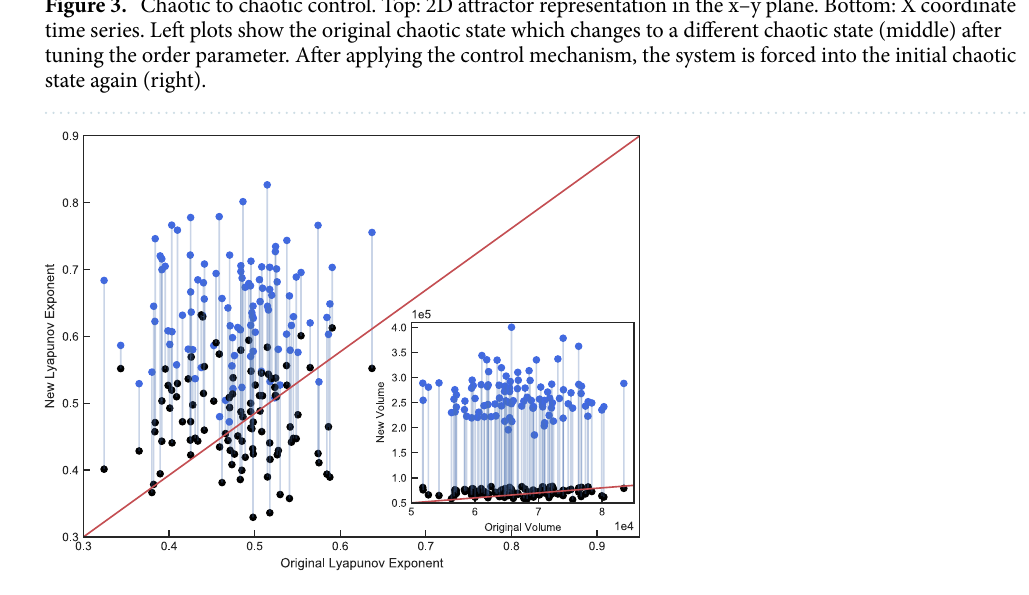
varies between the two states. The goal of the control procedure now is to not only force the dynamics of the system back to the behavior of the initial state Chaotic A , but also to return the attractor to its original size. Fig- ure 3 shows that both goals succeed. This is also confirmed by the statistical results, indicating that the largest Lyapunov exponent of the controlled system is perfectly close to the one of the uncontrolled original state. For the correlation dimension, however, there are no significant deviations between the two chaotic states. To give a more striking illustration of the statistical analysis, we show the results for each of the 100 random realizations in Fig. 4. The main plot scatters the largest Lyapunov exponents as measured for the original parameter set π against ∗ those measured after the parameters have been changed to π . While the blue dots represent the situation where the control mechanism is not active, the control has been switched on for the black dots. Furthermore, each pair of points is connected with a line that belongs to the same random realization. It is clearly visible that the control leads to a downwards shift of the cloud of points towards the diagonal, which is consistent to the respective aver- age values of the largest Lyapunov exponent shown in Table 1. In addition, the inlay plot shows the same logic but for the volume of the attractors being measured in terms of the smallest cuboid that covers the attractor. The control mechanism consistently works for every single realization and reduces the volume of the attractor back towards the initially desired state. We successfully applied our approach to other examples of controlling a chaotic state to another chaotic state, e.g. by varying the parameter σ as shown in the supporting information. The bottom half of Table 1 proves that our statements are also valid if one reverses the direction in the examples. For example, Periodic → Chaotic in the upper half of the table means, that an initially chaotic system changed into a periodic state and then gets controlled back into its initial chaotic state. In contrast, Periodic ← Chaotic in the lower half now means that the system initially is in the periodic state. It then shows chaotic behavior after the parameter change and finally is controlled back into the original periodic state—thus the opposite direction as above. It is evident that all examples also succeed in the opposite direction. This sup- ports our claim that the prediction based control mechanism works for arbitrary states.